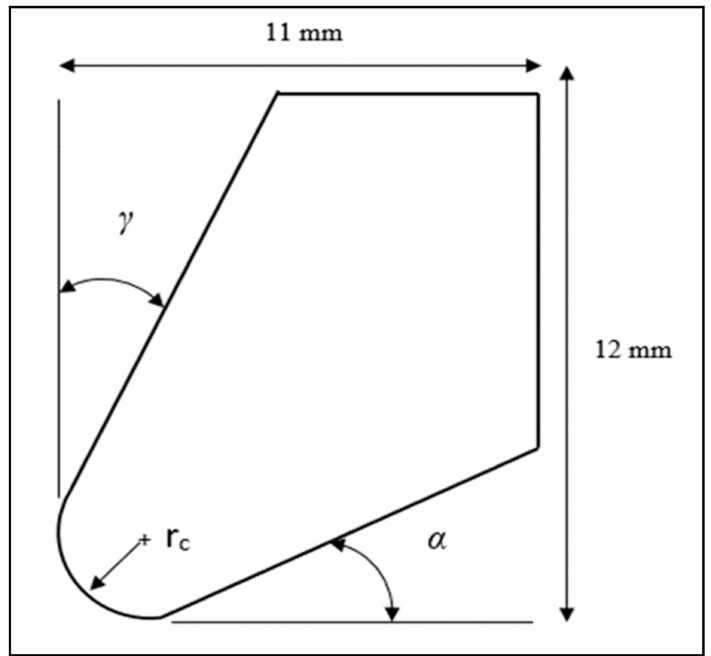
Figure 1. Tool model geometry ( r c , α , γ are the nose radius, the clearance angle and the rake angle,